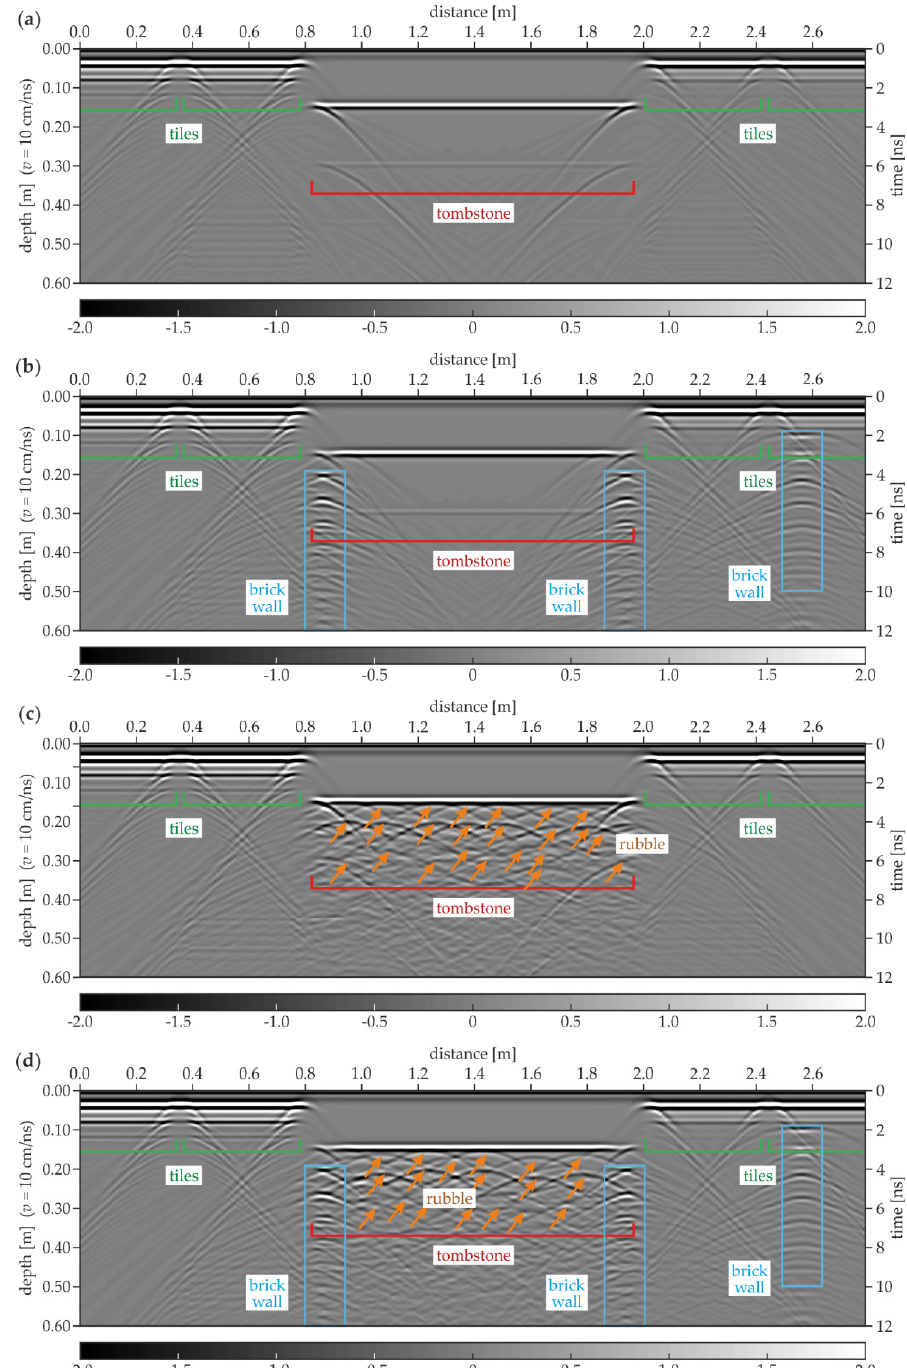
Figure 14. Numerical GPR B ‐ scans for the floor: ( a ) model #1.1; ( b ) model #1.2; ( c ) model #1.3; ( d ) model